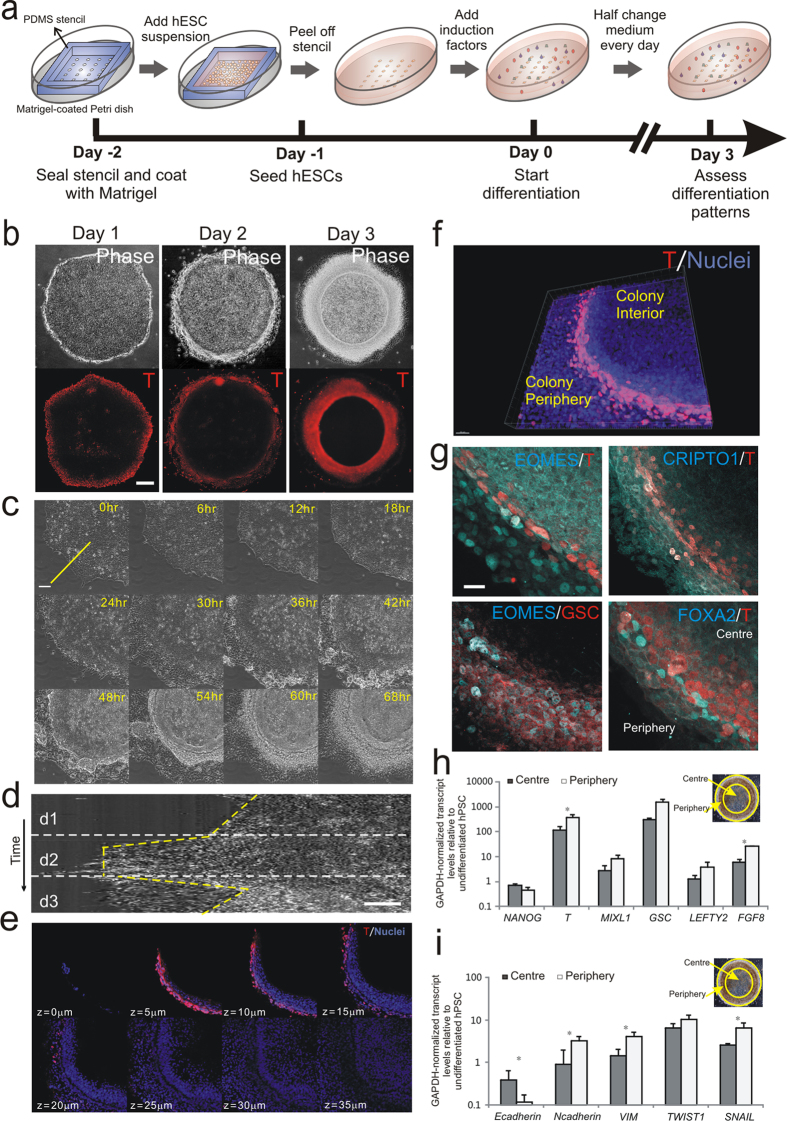
Formation of annular mesoendoderm pattern in μP-hPSC colony.(a) Schematic depicting micropatterning of hPSC colonies and mesoendoderm induction. (b) Phase and immunofluorescence images of mesoendoderm marker Brachyury (T) 1–3 days post mesoendoderm induction. Scale bar, 200 μm. (c) Montage from a 3-day phase imaging on a quarter section of a circular μP-hPSC colony. Scale bar, 100 μm. (d) Kymograph analysis showing the movement of cells along the yellow line shown in (c) throughout the 3-day live imaging time frame. Scale bar, 50 μm. (e, f) Confocal z-stack sections of T (red) and cell nuclei (blue)-labeled multicellular annular structure (e) and its 3-D reconstruction image (f) on day 3. Scale bar, 30 μm in (f). (g) Immunofluorescence images of mesoendoderm markers EOMES, CRIPTO1 GSC and FOXA2. Scale bar, 20 μm. (h,i) Gene expression levels of mesoendoderm markers (h) and EMT markers (g) in colony centre and periphery on day 3 relative to undifferentiated hPSCs. Data are average ± s.d. of three experiments with duplicate samples. *, p < 0.05 in paired t-test. Insets, phase image showing colony periphery and centre.